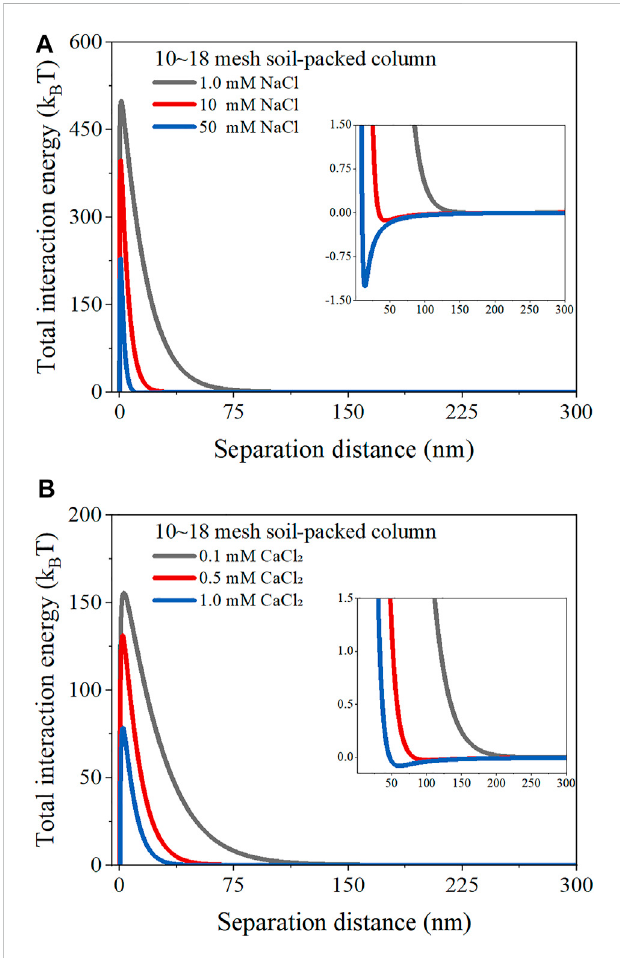
FIGURE 3 DLVO interaction energy versus surface-to-surface separation distance for biochar nanoparticles (BC-NP) and soil particles at varying concentrations of NaCl [1.0, 10, and 50 mM; (A) ], CaCl 2 [0.1, 0.5, and 1.0 mM; (B) ] in columns packed with 10~18 mesh soil. Insets highlightthesecondaryminimum.AstheDLVOinteractionenergyinthe 18~35 and 35~60 mesh soil-packed columns were similar to that in the 10~18 mesh soil-packed columns, we did not show